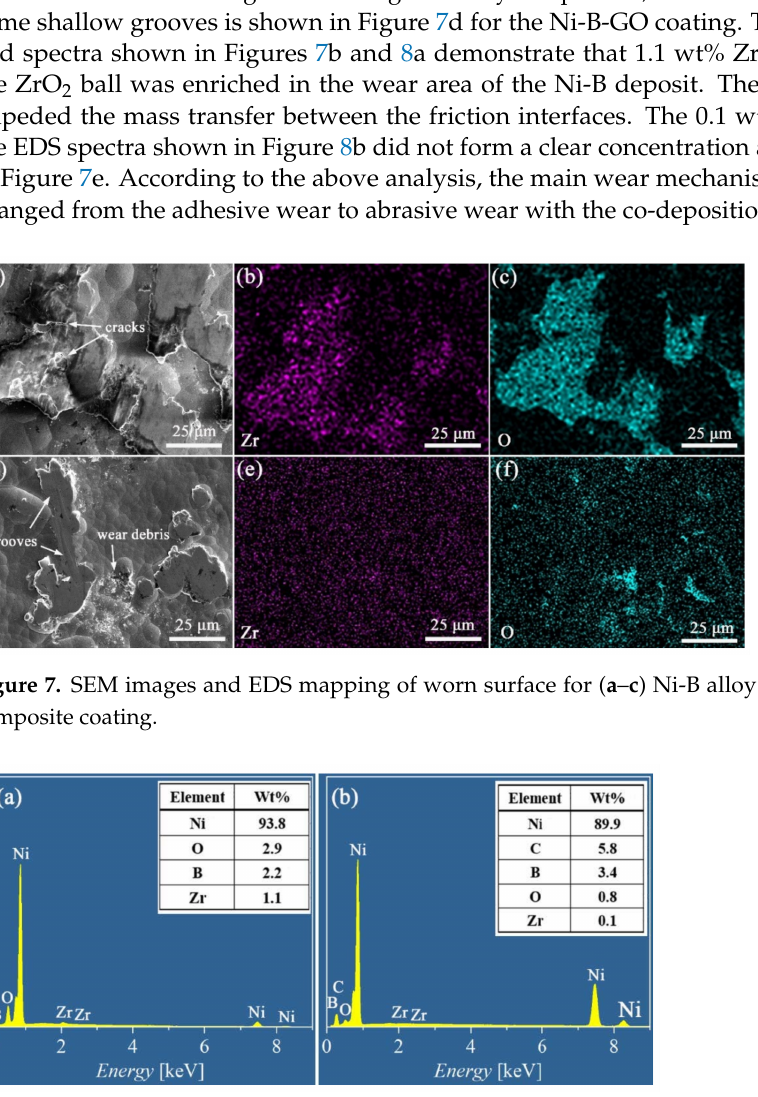
Figure 8. EDS spectra of worn surface for ( a ) Ni-B alloy and ( b ) Ni-B-GO composite